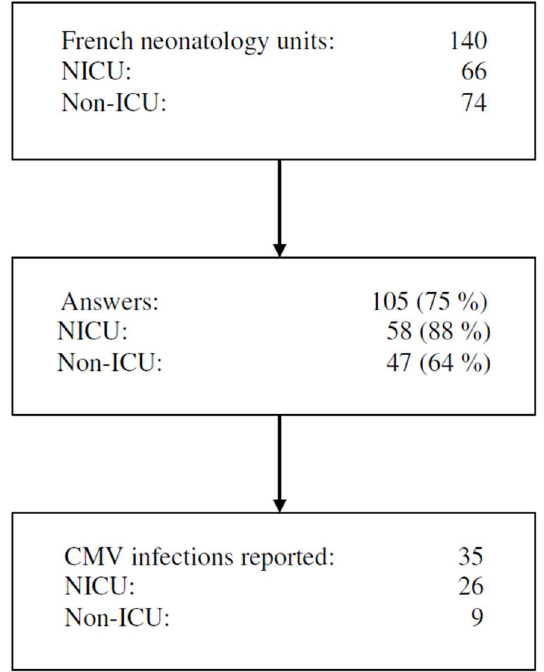
Figure 1. Flowchart. NICU: neonatal intensive care unit; ICU: intensive care unit; CMV: cytomegalovirus.